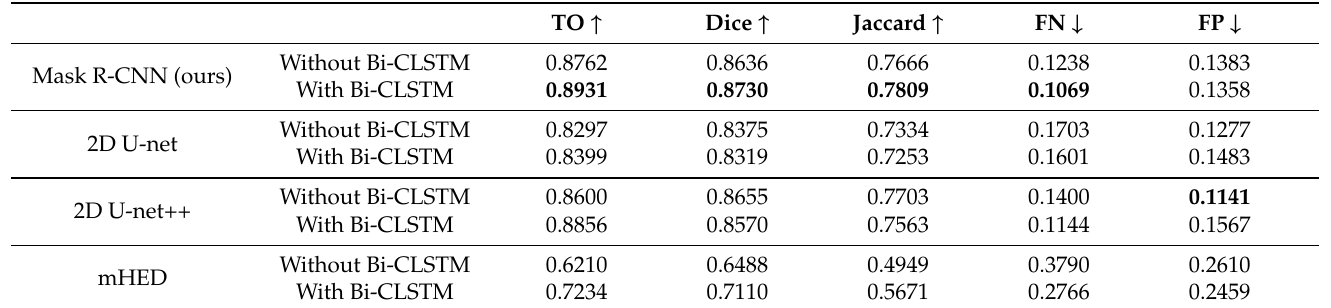
Table 2. Thrombus ROI segmentation results comparison among four 2D-based CNN backbones for use in our Bi-CLSTM method.